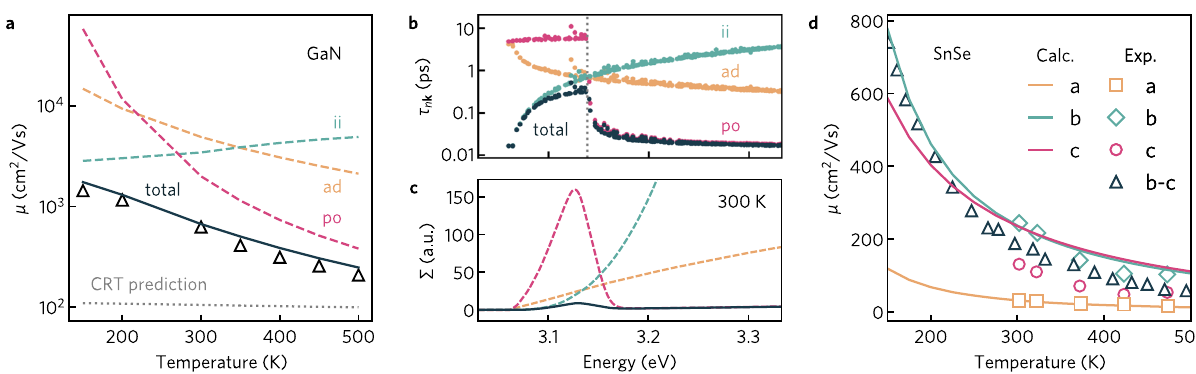
Fig. 3 Temperature-dependent transport properties of GaN and SnSe. a Comparison of the electron mobility, μ , of GaN against experiment (black triangles, 92 ). Mobility limited by ionized impurity (teal, ii), acoustic deformation potential (orange, ad), and polar optical phonon scattering (pink, po) is indicated in dashed lines. Total mobility taking into account all scattering mechanisms (1 = τ ii n relaxation time (CRT) calculations with τ = 10 fs is given by dotted gray line. b Electron lifetimes, τ n k and ( c ) spectral conductivity, Σ , arising from different scattering processes in GaN at 300 K. The valence band maximum is set to zero eV. In ( b ), the vertical dotted gray line indicates the energy of the effective polar phonon frequency, ω po . d Comparison of the direction-dependent mobility of SnSe against experiments — a (orange), b (teal), c (pink) points from ref. 66 , b – c (black) points from ref.